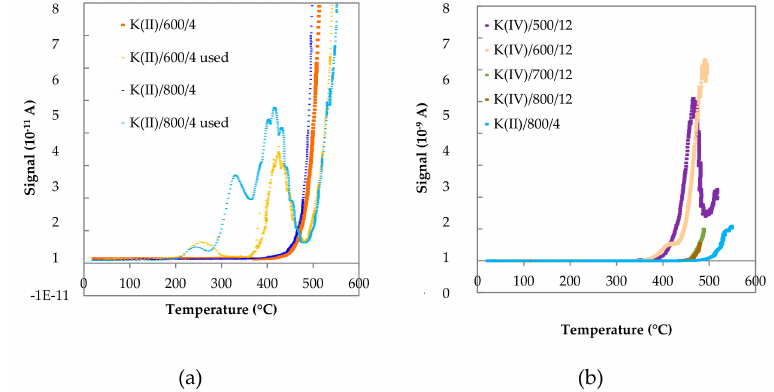
Figure 9. Atomic K desorption flux as a function of temperature for ( a ) K(II) / 600 / 4 and K(II) / 800 / 4 fresh and used samples and ( b ) used K(II) / 800 / 4 and K(IV) / y / 12